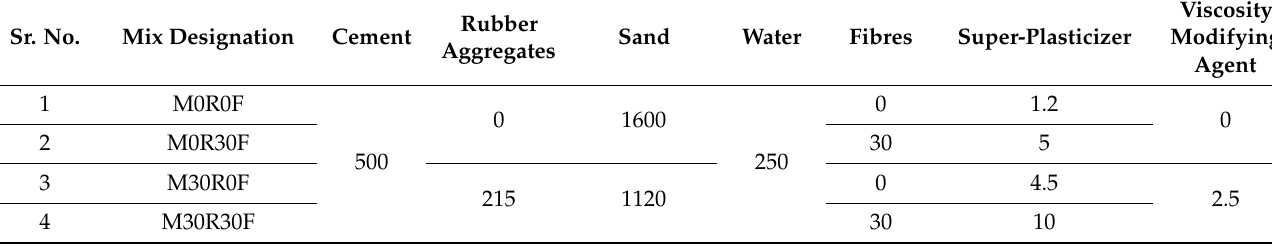
Table 3. Mixture design (kg/m 3 ).